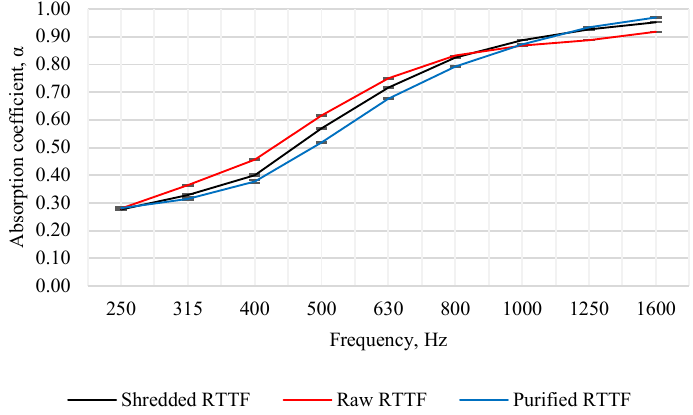
Fig. 6. Comparison of non-conventional materials options: shredded RTTF vs. Raw RTTF vs. purified RTTF. In measured frequency range , raw RTTF performance on sound absorption is better, comparing to shredded and purified RTTF. At higher frequency from 1000 Hz sifted RTTF moves forward and its absorption comparing to shredded and raw RTTF is higher.